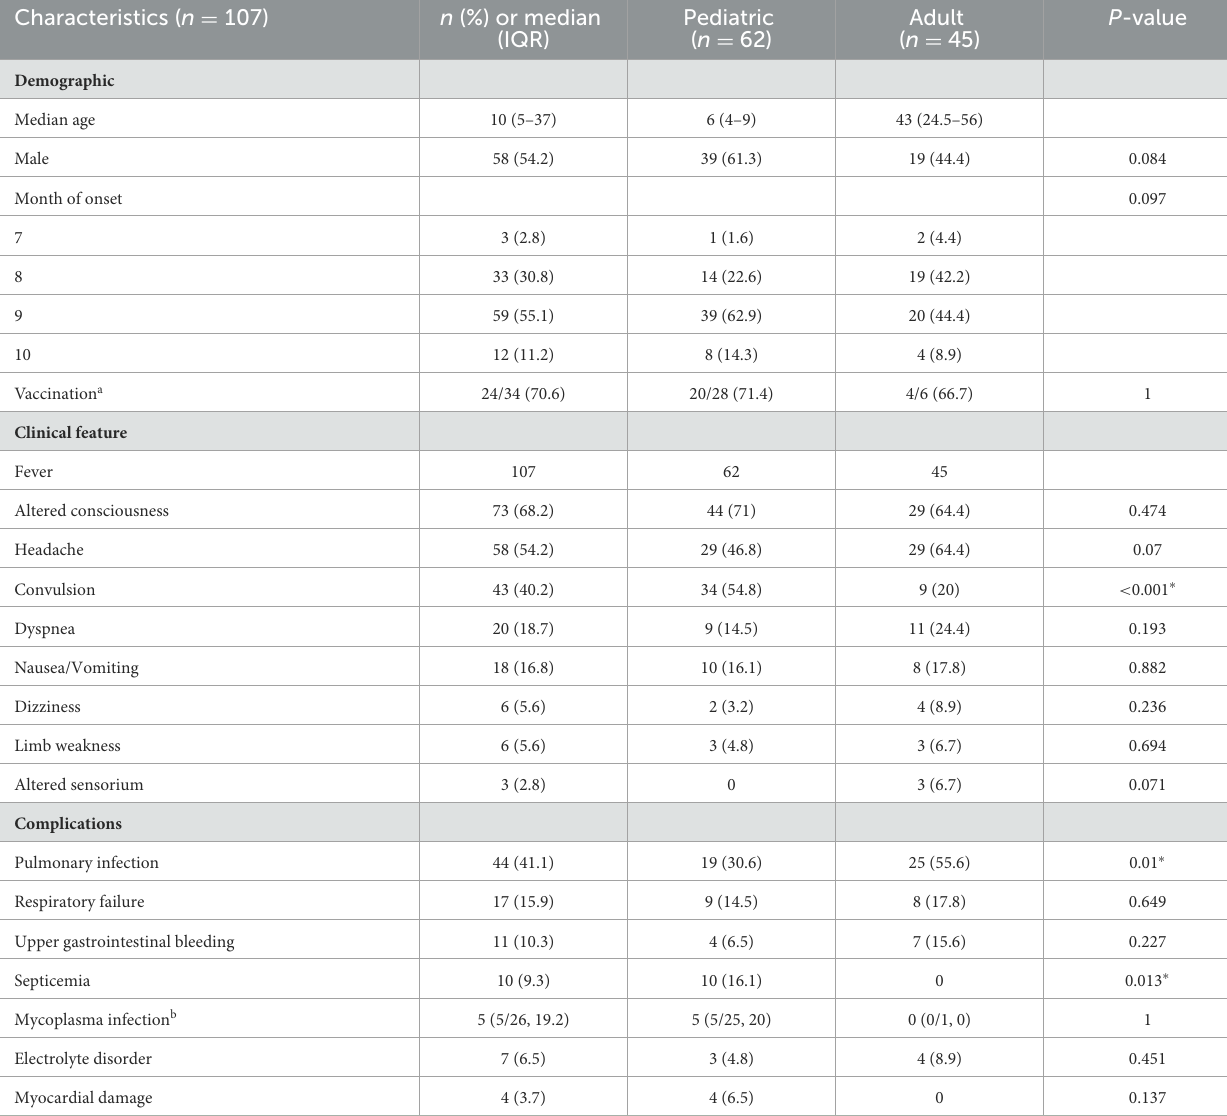
TABLE 1 Demographic and clinical characteristics were recorded in both groups of pediatric and adult patients with JE. Characteristics ( n =